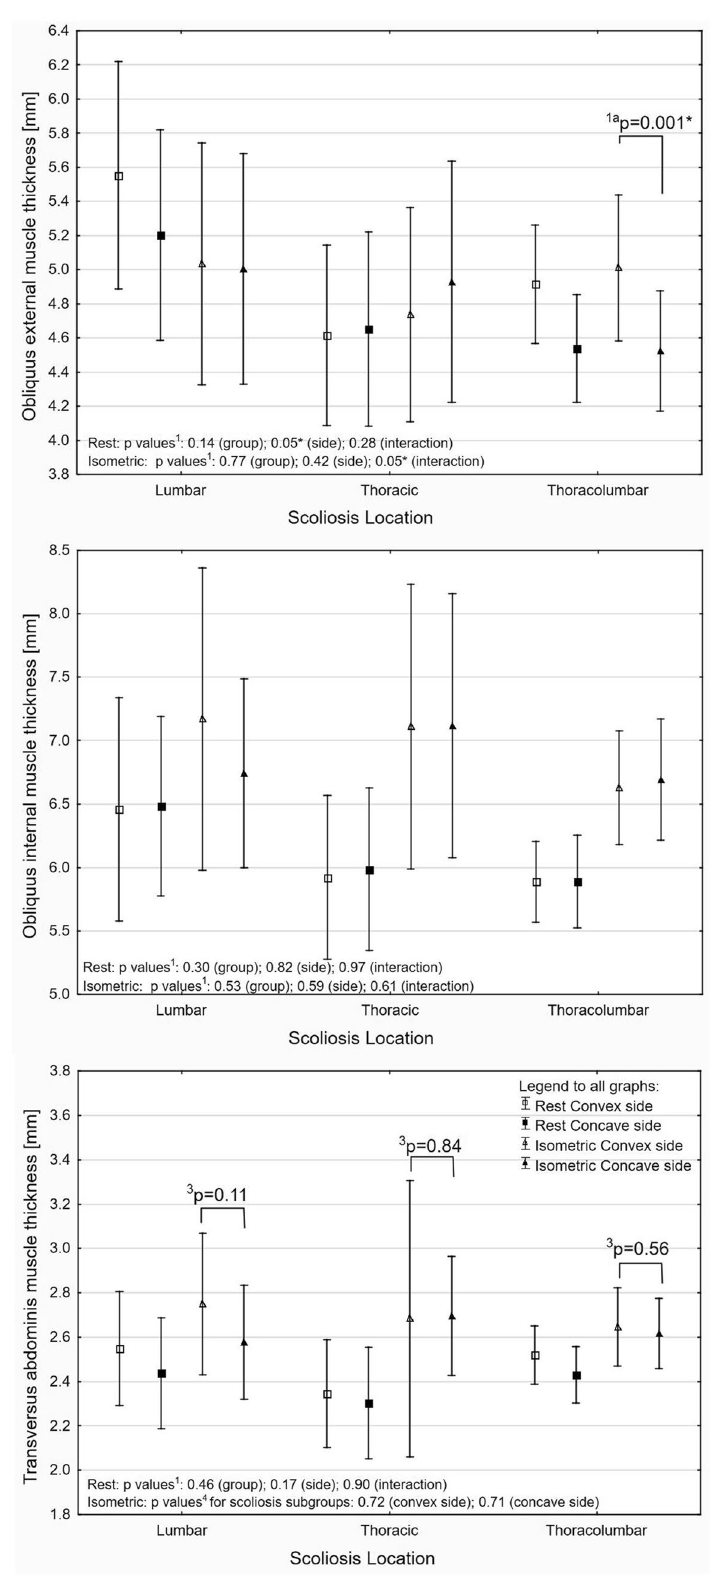
Figure 3. Absolute muscle thickness at rest and during isometric contraction in idiopathic scoliosis subgroups with p values from ANOVA 1 (planned comparisons 1a ), Wilcoxon test 3 or Kruskal–Wallis test 4 (*significant